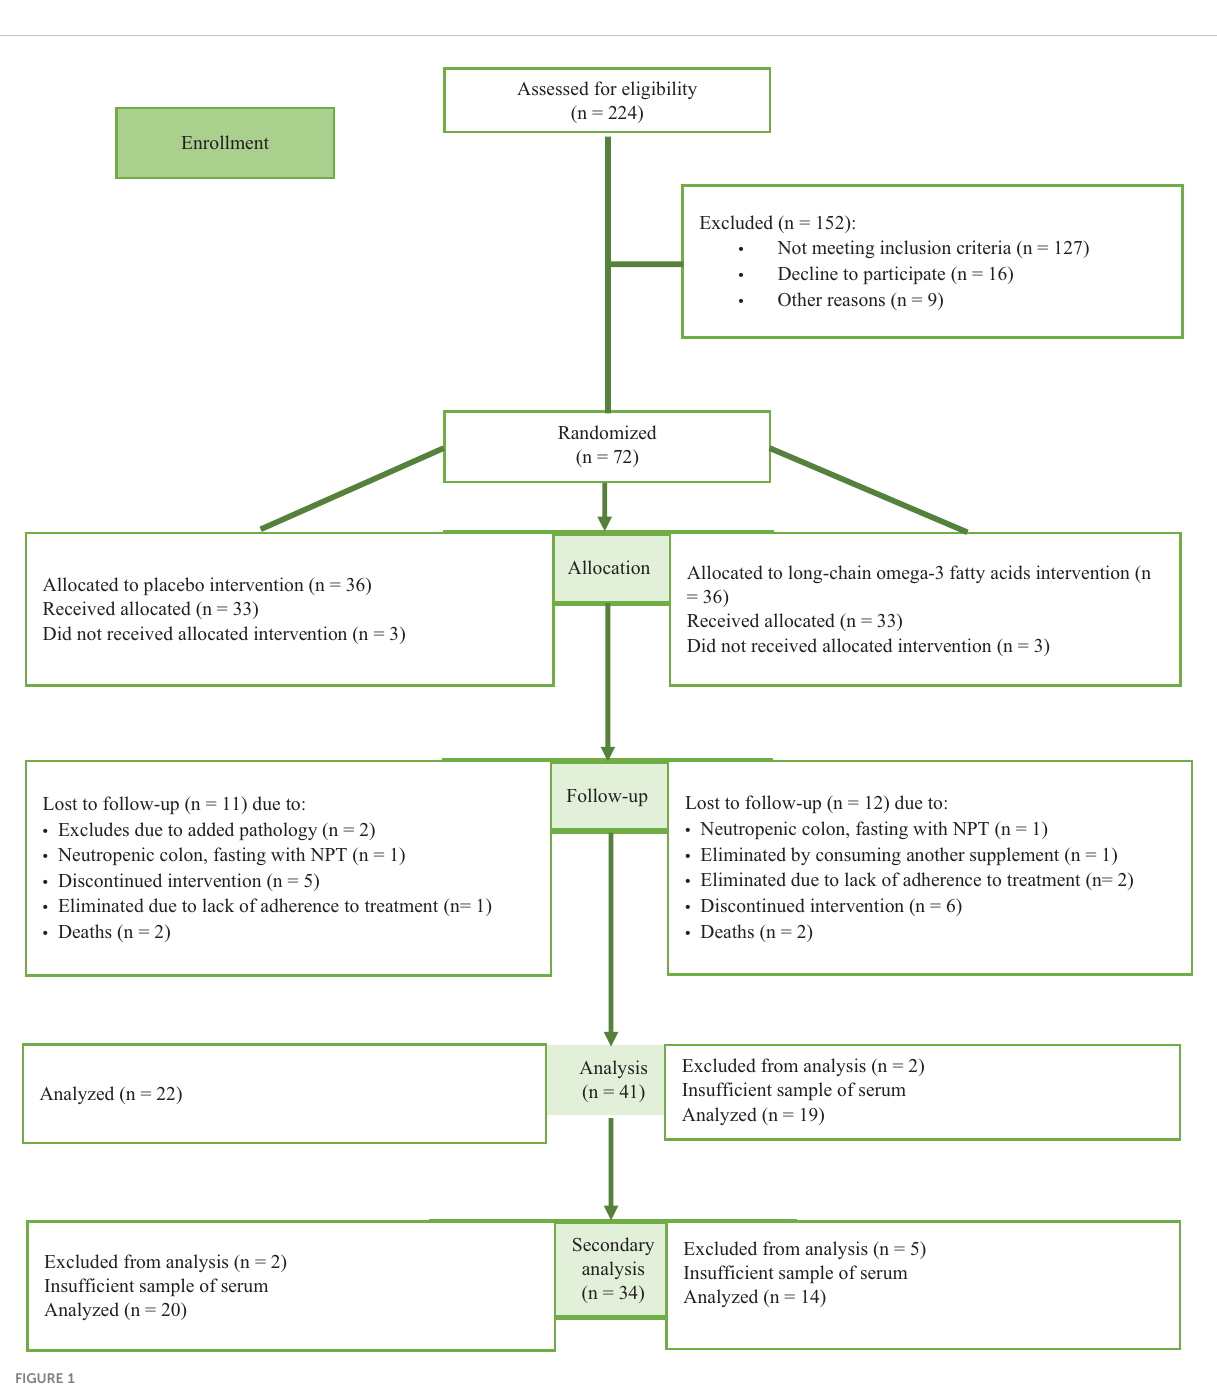
FIGURE 1 Flow diagram of the progress through the phases of the clinical trial and present